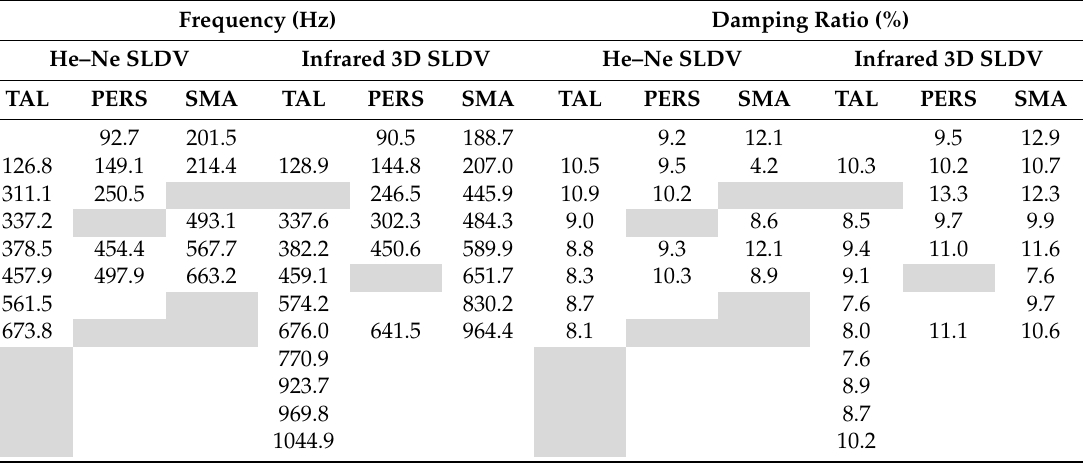
Table 4. Modal parameters of three specimens estimated from measurements conducted by two instruments: He–Ne SLDV and infrared 3D SLDV. The gray cells are the mode shapes that Polymax estimate was not able to detect.